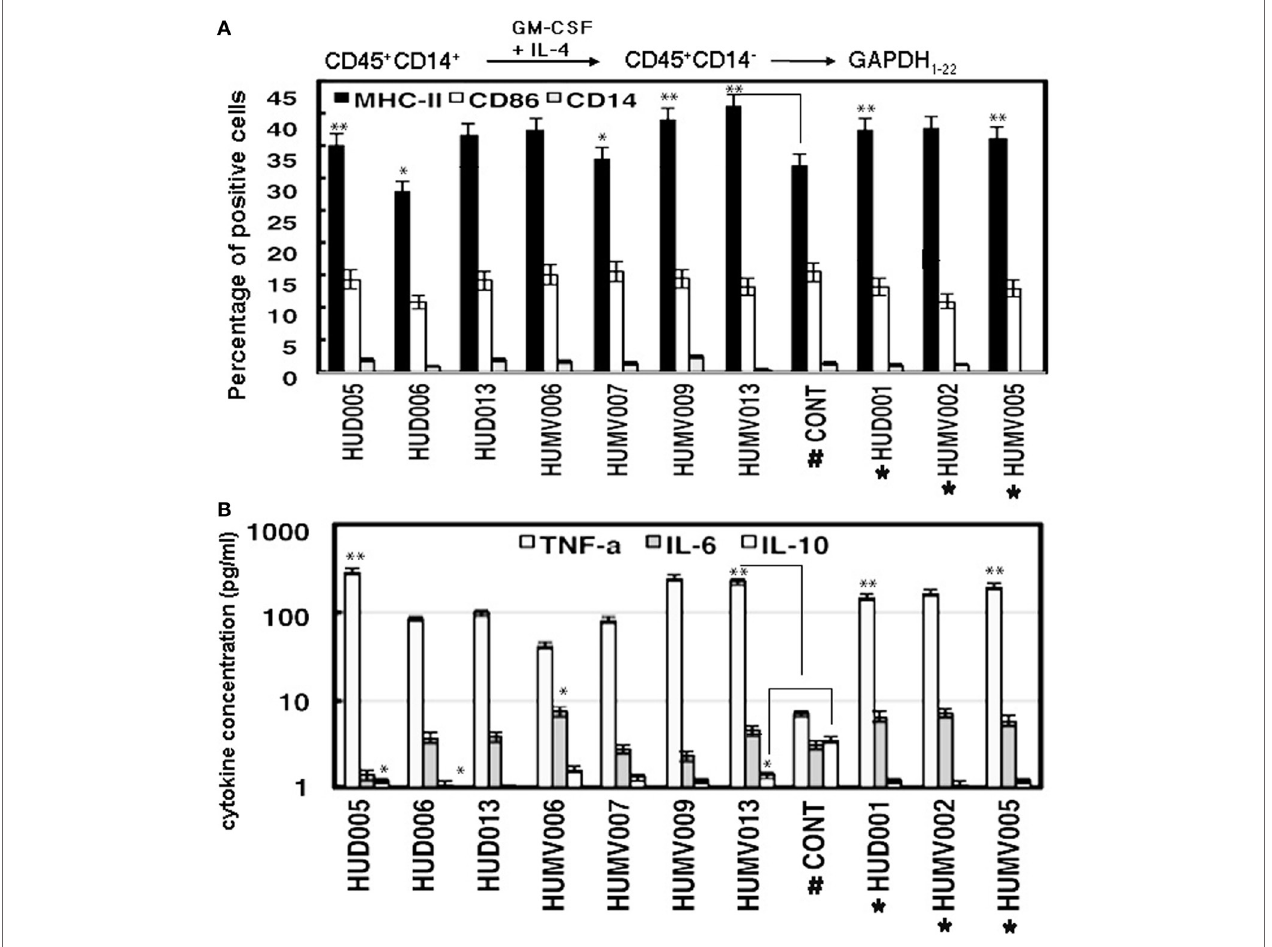
FIGURe 2 | activation of MoDC from listeriosis patients with cancer . (a) Differentiated and GAPDH 1–22 -activated MoDC from listeriosis patients with tumors (Methods in Supplementary Material) were examine for cell surface expression. Results are expressed as the percentages of positive cells ± SD. * P ≤ 0.05; ** P ≤ 0.01. (B) Cytokine concentration in supernatants of GAPDH 1–22 -activated MoDC. Results are expressed as the mean of cytokine concentrations (pg/ml) ± SD and ANOVA was applied. * P ≤ 0.05; ** P ≤